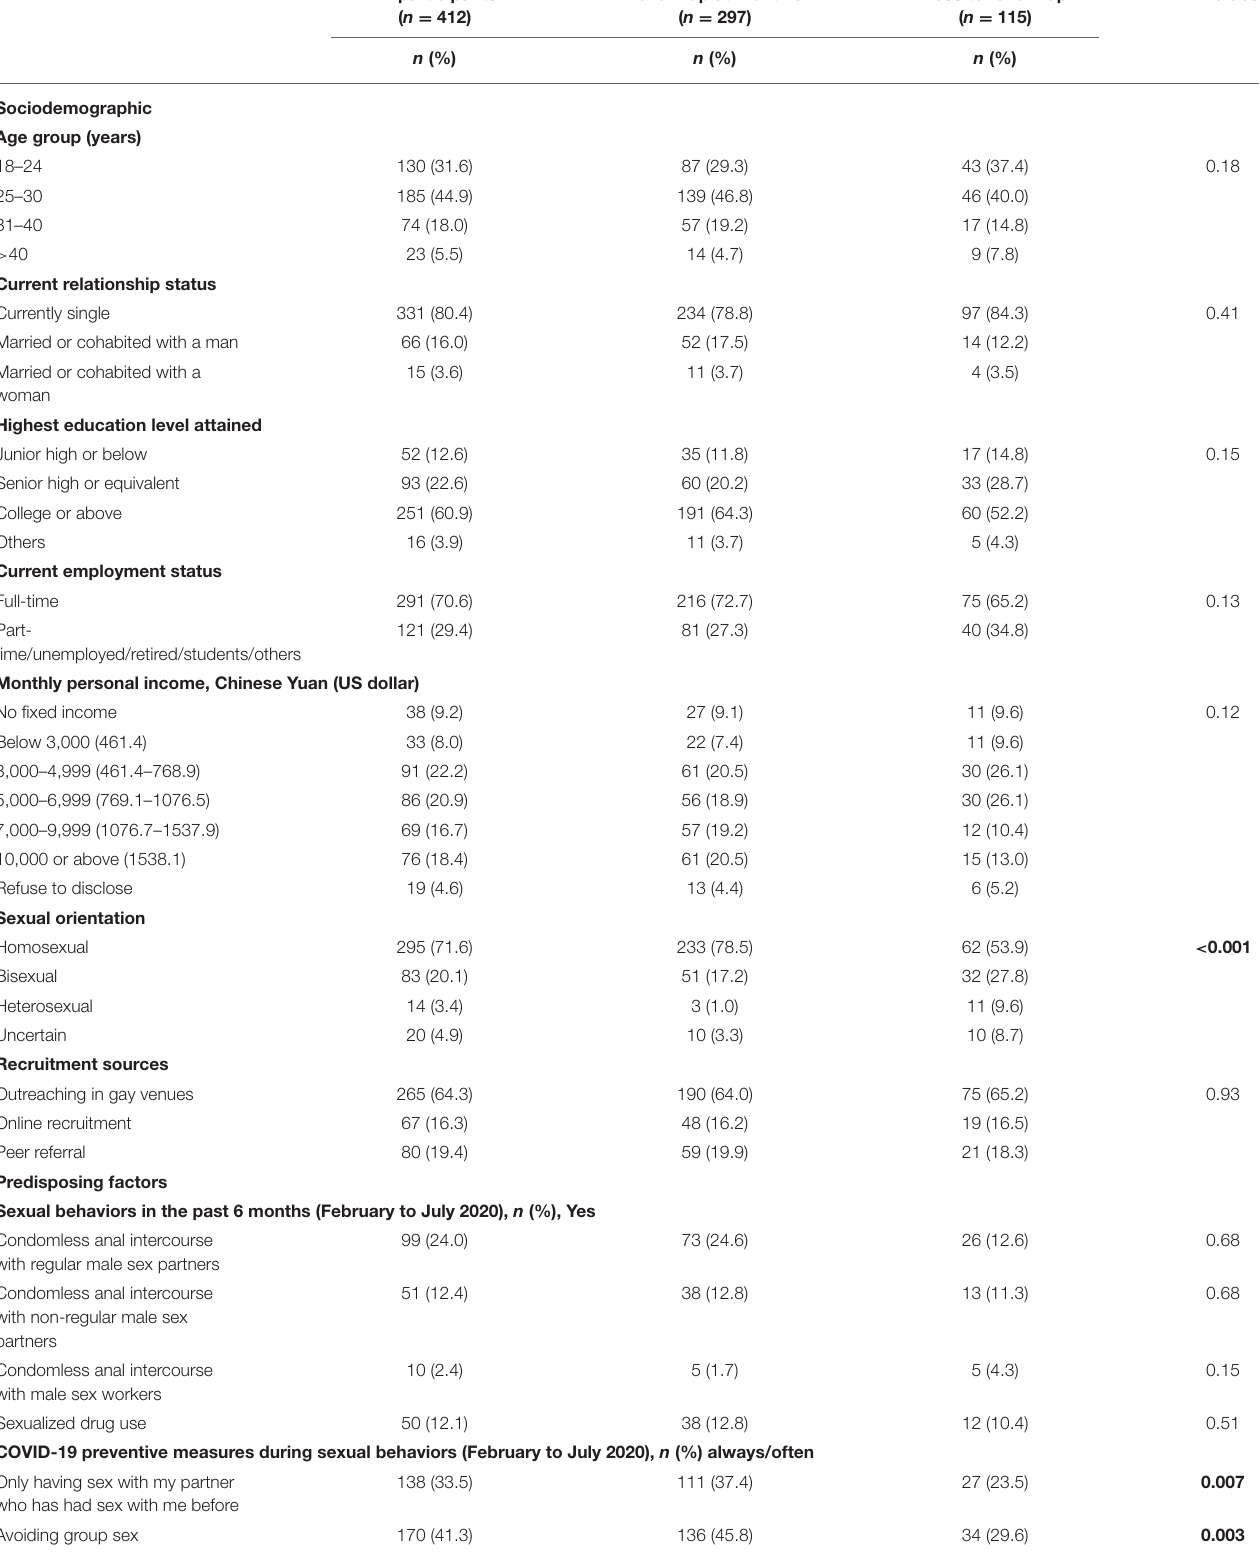
TABLE 1 | Baseline characteristics of